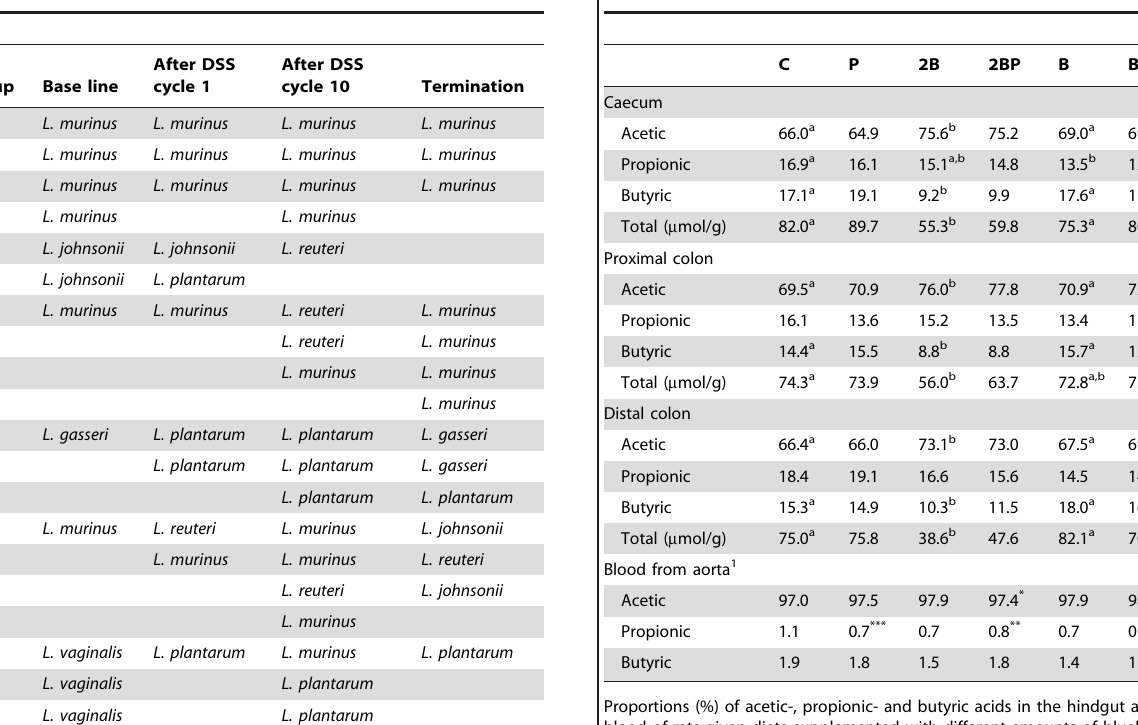
Table 5. Identification to species level of faecal lactobacilli. Table 6. SCFAs in colon content and blood